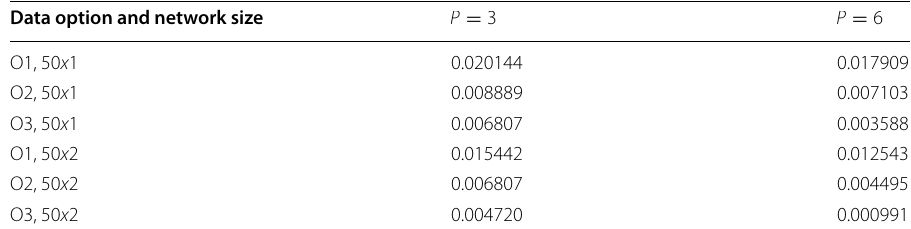
Table 2 Neural network training errors, clutter and noise Data option and network size P = 3 P = 6